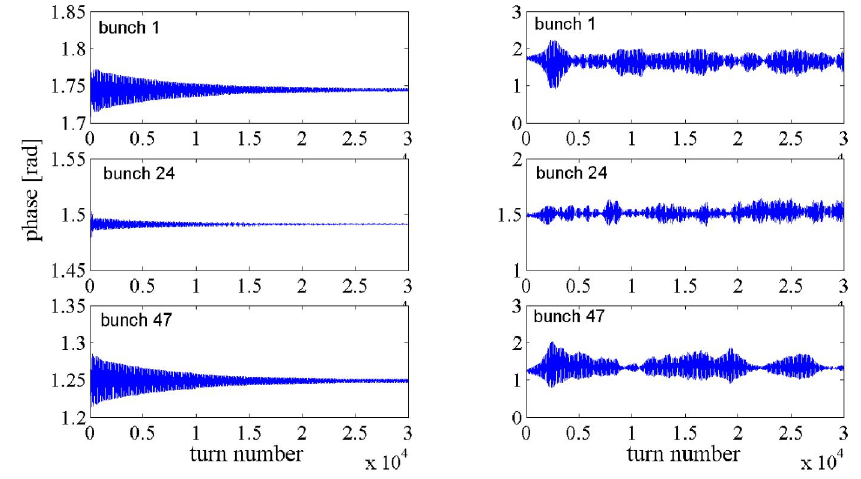
(cid:4) 1 : 6 A into 47 bunches) with LFB on and b